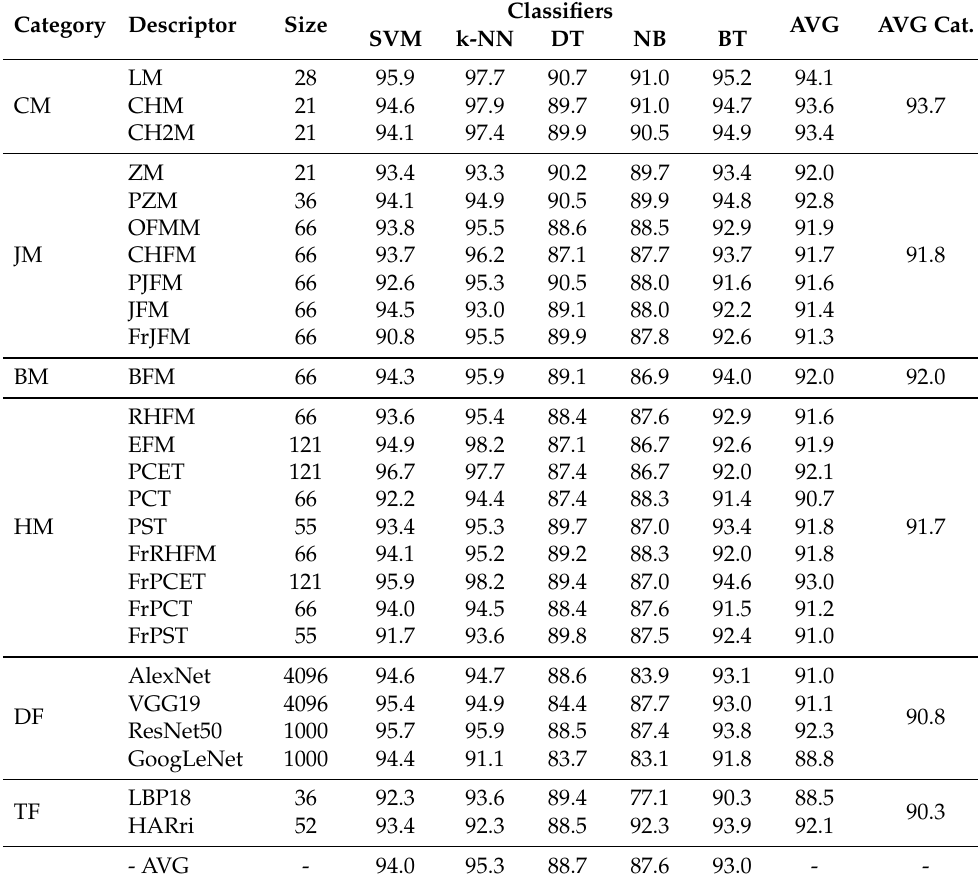
Table 4. Results obtained on the Brain-Tumor-MRI data set with all the analysed features, for which we report the categorisation (category column, CM—Cartesian moments, JM—Jacobian moments, BM—Bessel–Fourier moments, HM—harmonic moments, DF—deep features, and TF—texture fea- tures), the name (descriptor column), the feature size (size column), the accuracy obtained with all the tested classifiers (SVM, k-NN, DT, NB, BT columns) and the average accuracy value (AVG column). On the right (AVG cat.), we also report the average accuracy value of each category of features and on the bottom (AVG row), we report the average accuracy per